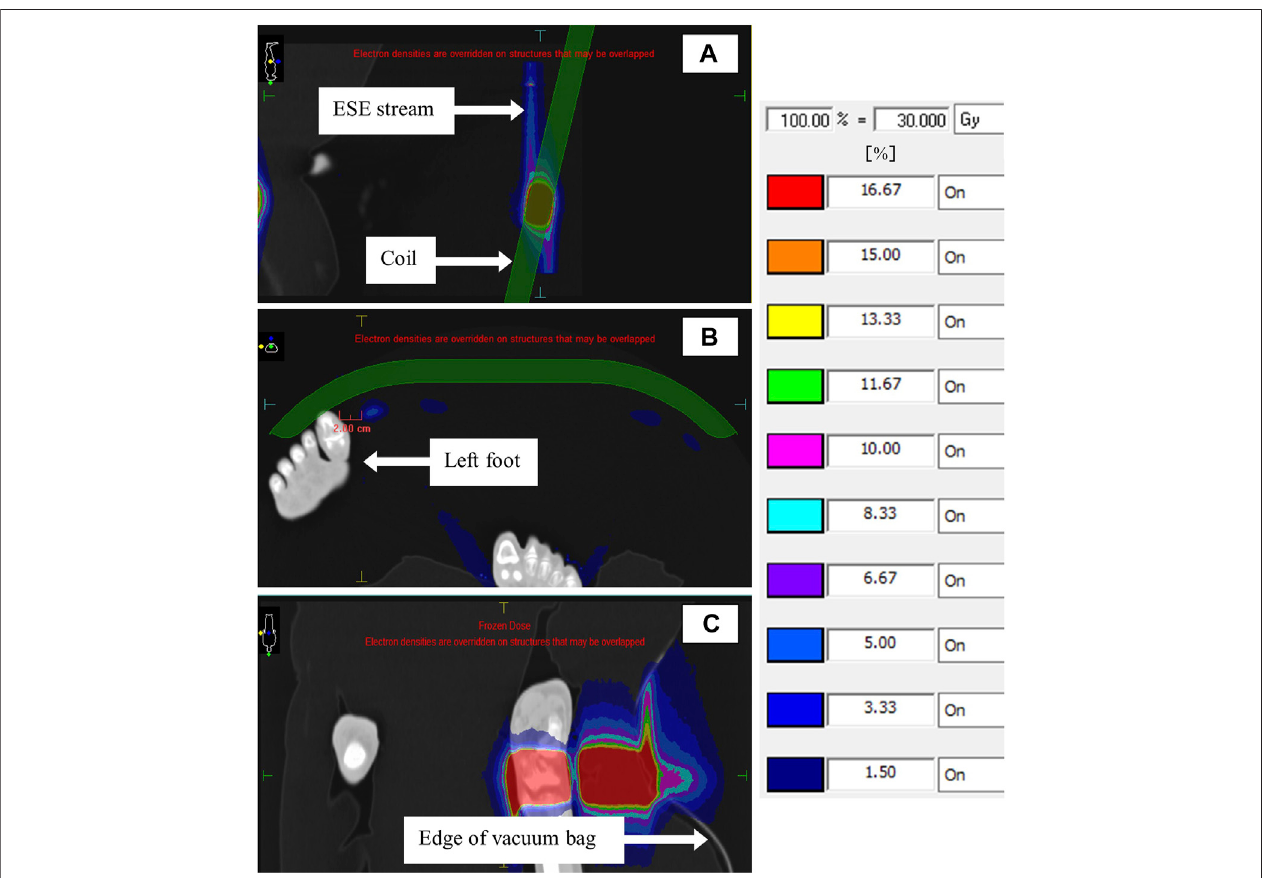
FIGURE 10 | TPS images showing ESE doses for the patient case. The sagittal image in (A) shows ESE streams above and below the coil, and the transverse image in (B) shows the proximity of one such stream to the patient ’ s left foot. In (C) , a coronal slice through the patient ’ s right ankle shows ESE emanating from the vacuum immobilization bag. Note the patient orientation icon in the top left.